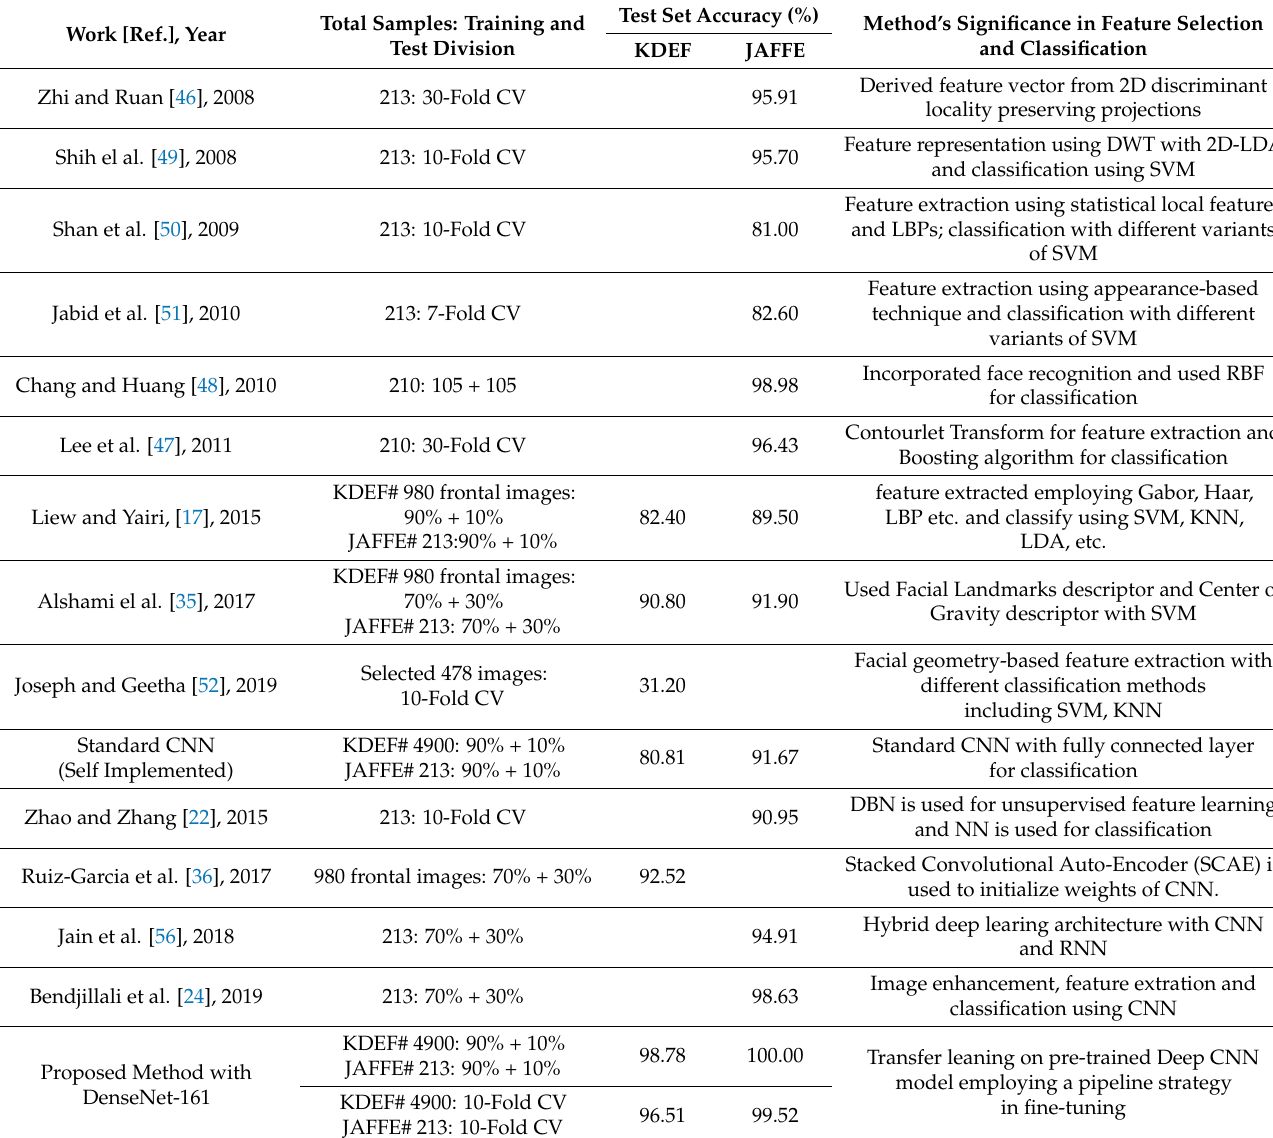
Table 6. Comparison of the accuracy of proposed method with existing works on KDEF and JAFFE